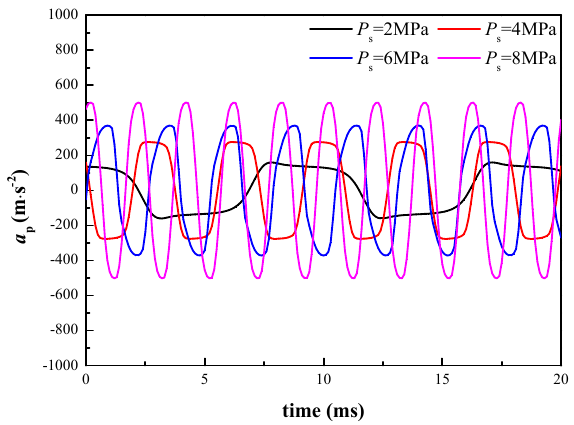
Figure 15. Accelerations of di ff erent supply pressures.